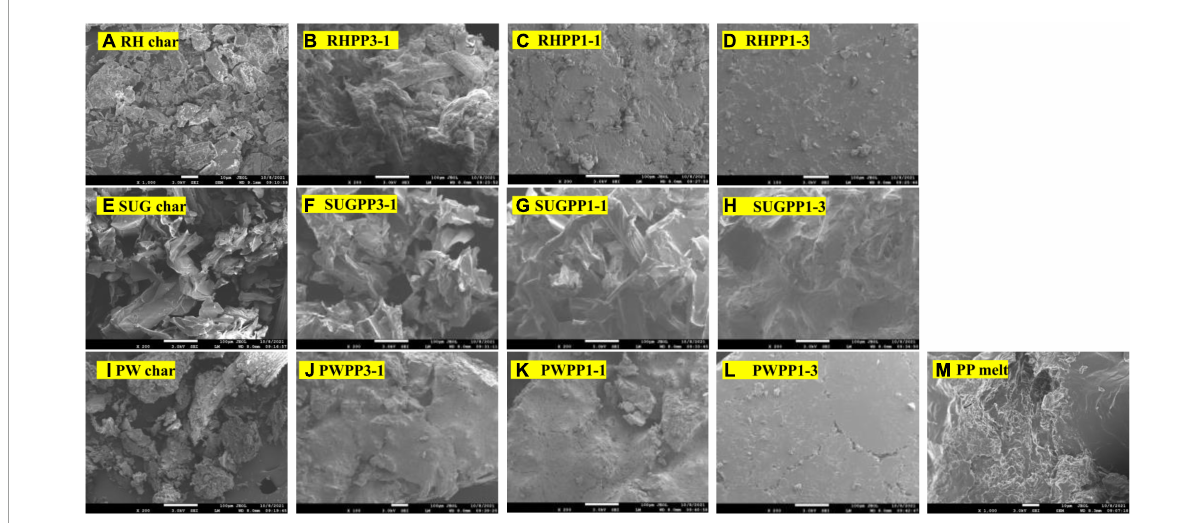
FIGURE5 SEM analyses of the char samples and the co-pyrolysis melt under 380 ◦ C: (A) RH char, (E) SUG char, (I) PW char, (B) RHPP3-1, (C) RHPP1-1, (D) RHPP1-3, (F) SUGPP3-1, (G) SUGPP1-1, (H) SUGPP1-3, (J) PWPP3-1, (K) PWPP1-1, (L) PWPP1-3, and (M) PP.